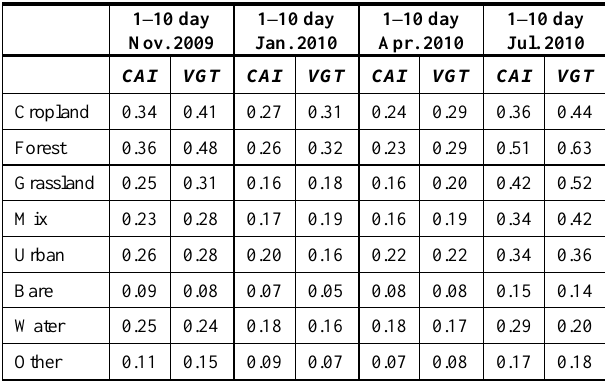
Figure 4. Histogram of regression standardized residual between SPOT VGT and GOSAT CAI NDVI in November 2009 (a), January 2010 (b), April 2010 (c) and July 2010 (d). Table 3. Statistices of the mean NDVI values from GOSAT CAI and SPOT VGT in different land cover during four time